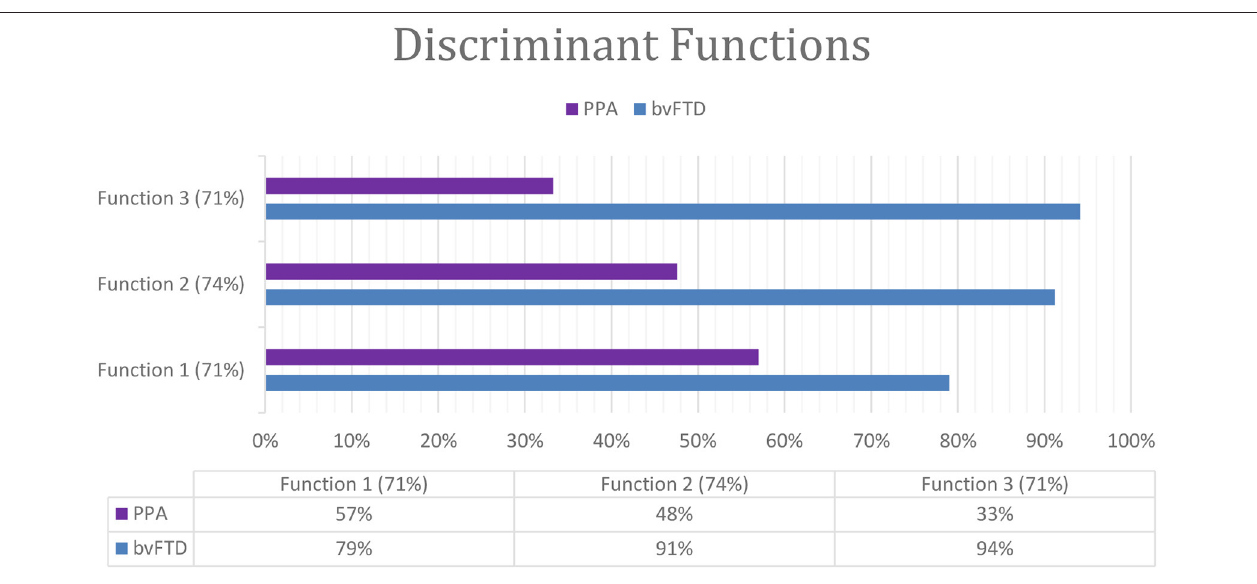
FIGURE 3 | Classification of dementia by the discriminant functions (subtest and